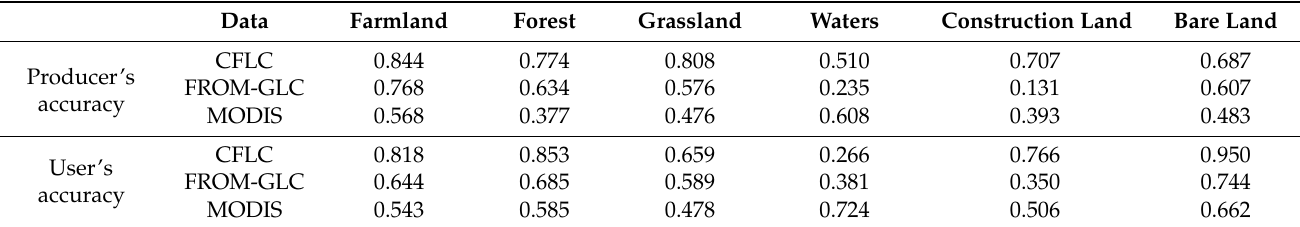
Table 4. Comparison of classification accuracy based on Geo-Wiki.